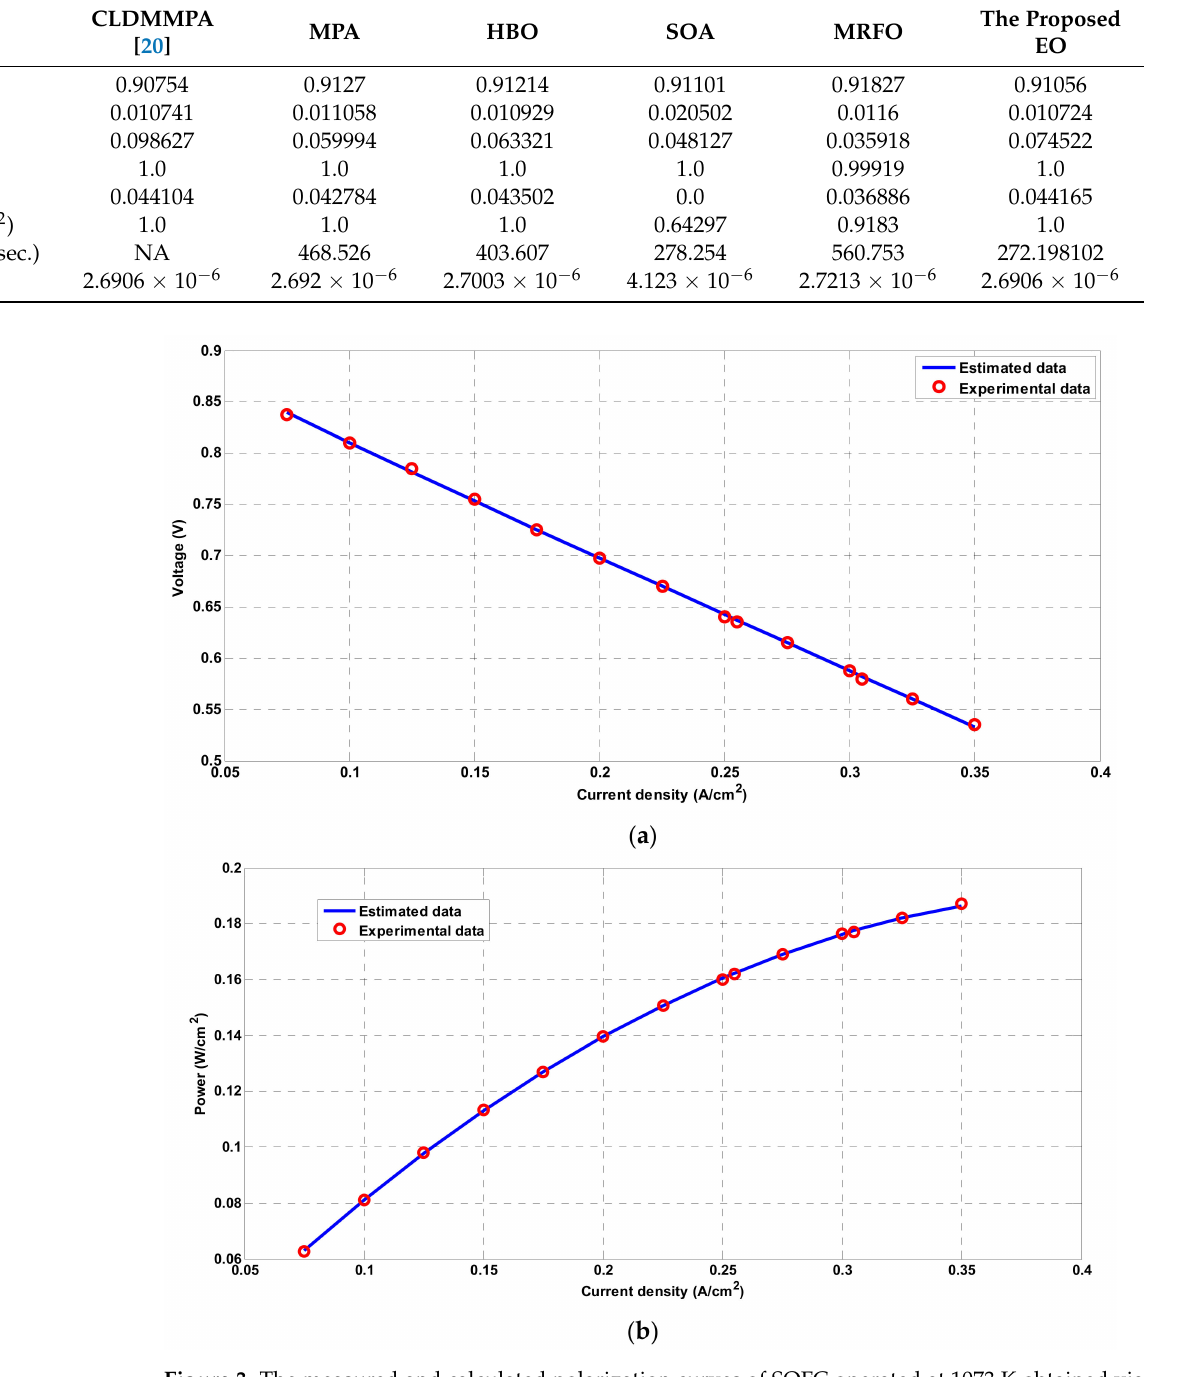
Figure 3. The measured and calculated polarization curves of SOFC operated at 1073 K obtained via EO at ( a ) current density-voltage, ( b ) current